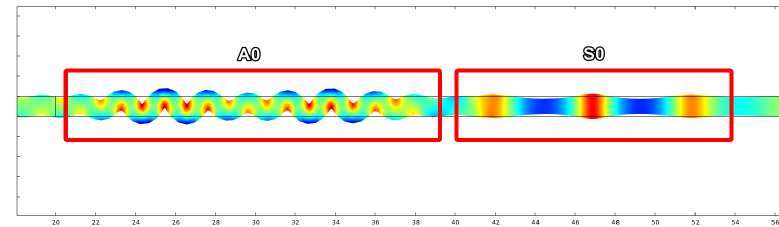
Figure 4. Presence of the A 0 & S 0 modes.